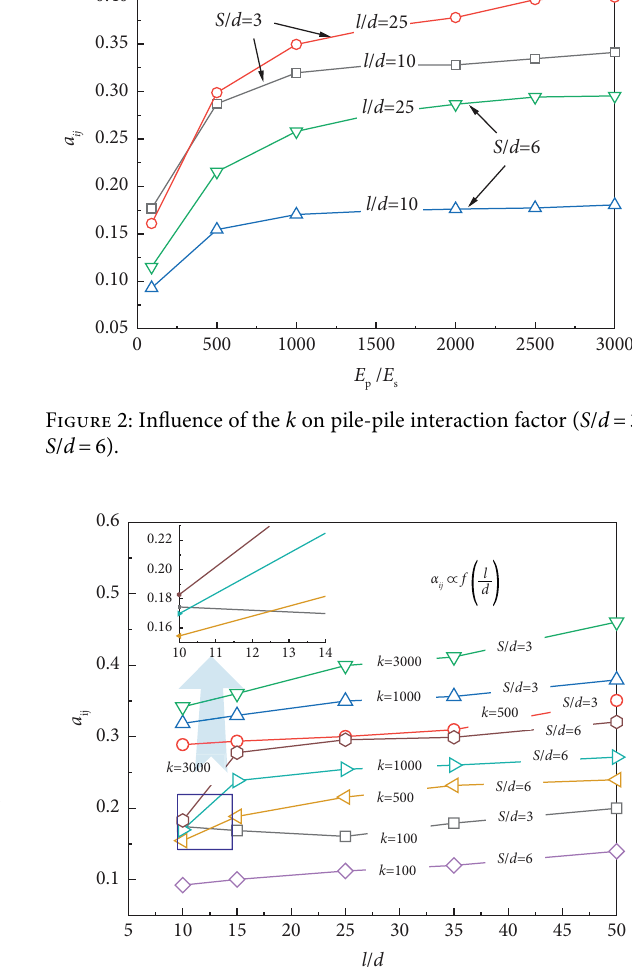
Figure 3: Infuence of l / d on the pile-pile interaction factor ( S / d � 3, S / d � 6).